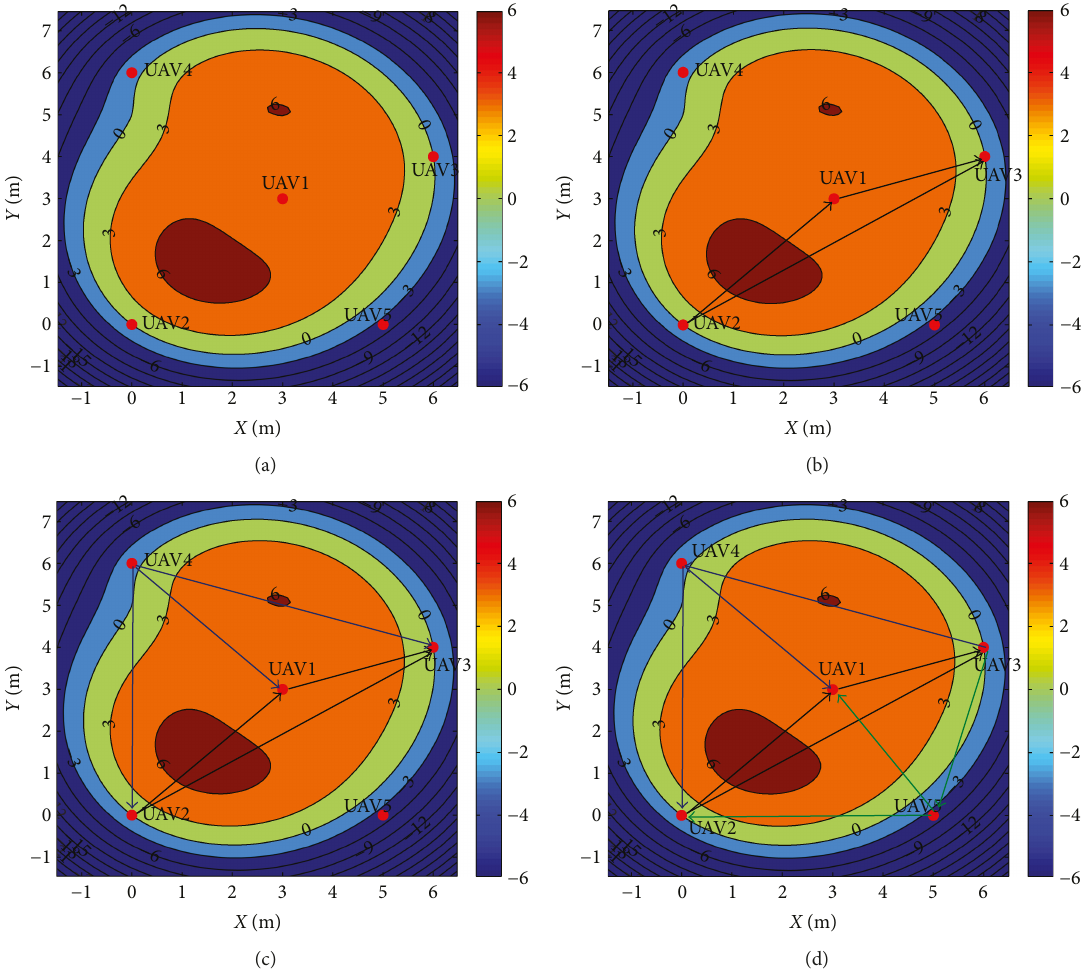
Figure 10: Generation of the 3D minimally persistent graph based on G10 with the top-down strategy. (a) The contour map of UAVs. (b) The formation generation in the fi rst subspace. (c) The formation generation in the second subspace. (d) The formation generation in the third